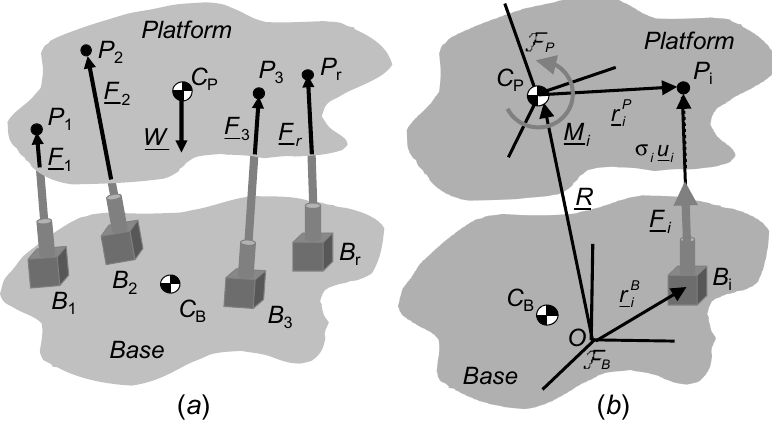
Fig. 5. Generalized multi-axis vibration